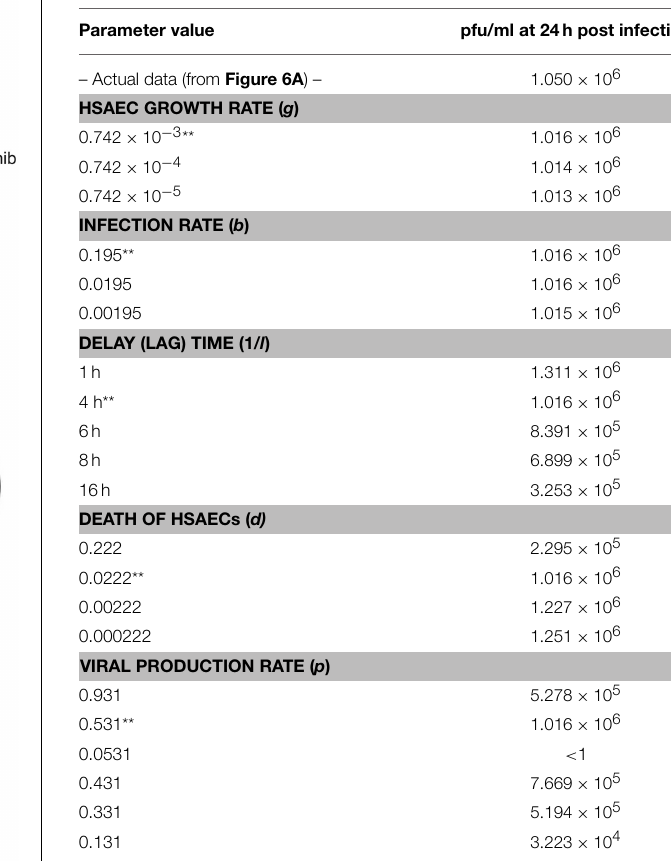
TABLE 3 | Model results (pfu/ml at 24h) with adjusted parameter